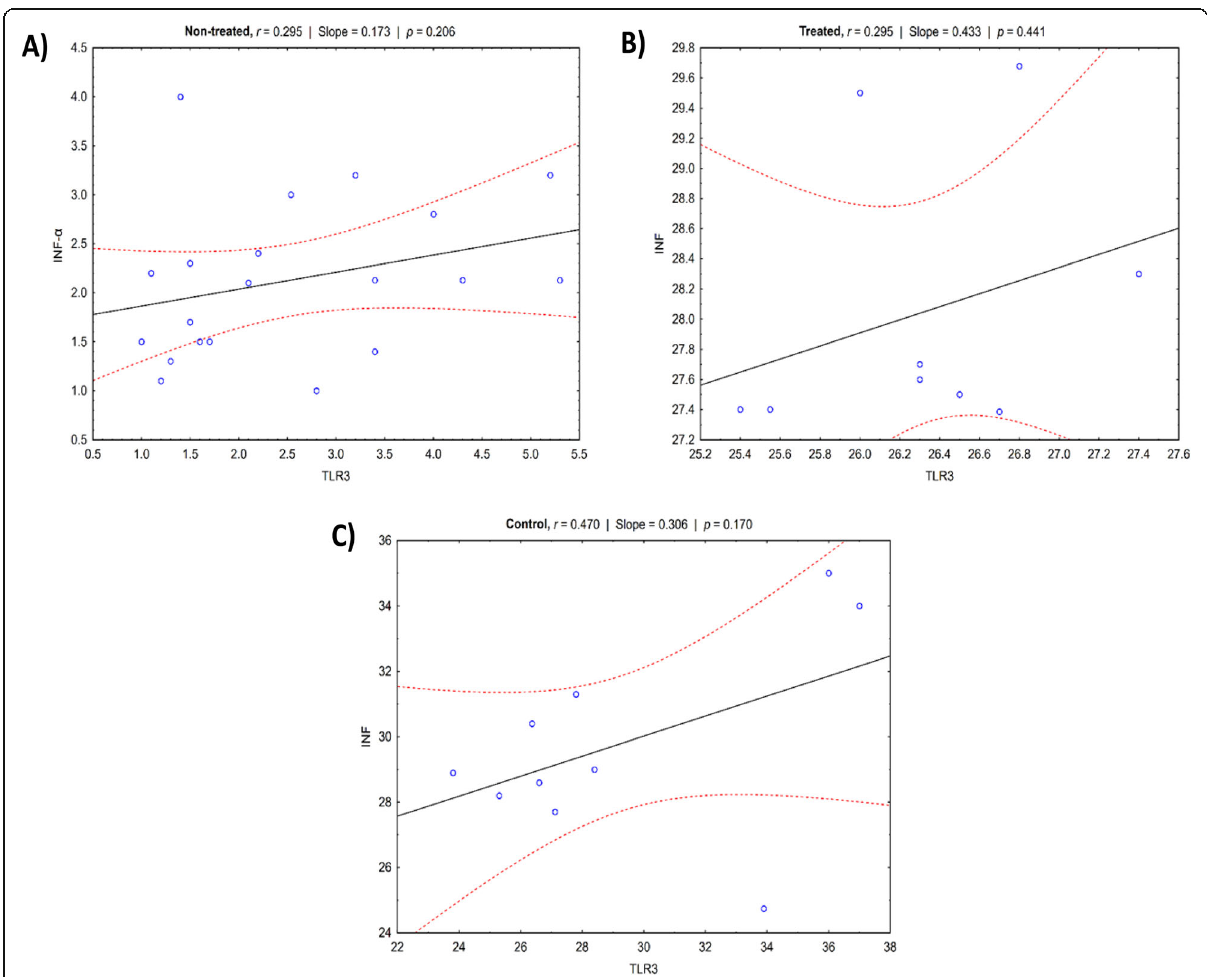
Fig. 4 a The correlation between expression levels of TLR3 and IFN- α in non-treated chronic HCV patients. b The correlation between expression levels of TLR3 and IFN- α in treated HCV group. c The correlation between expression levels of TLR3 and IFN- α in the control